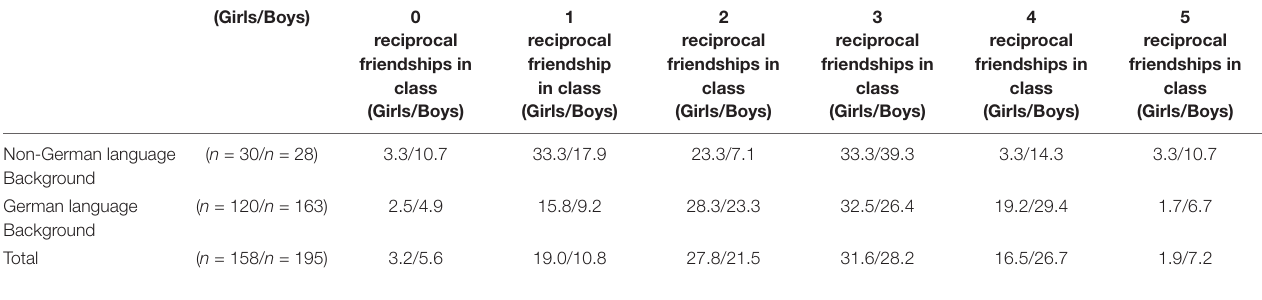
TABLE 6 | Distribution of the percentage of stable friendships between the first (T1) and the second (T2) measurement point for students with and without a migration